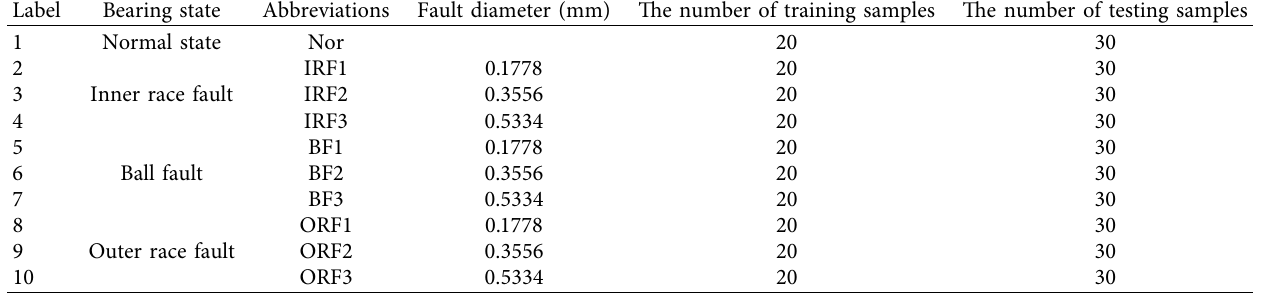
Table 2: Detailed information of different working states of bearings.